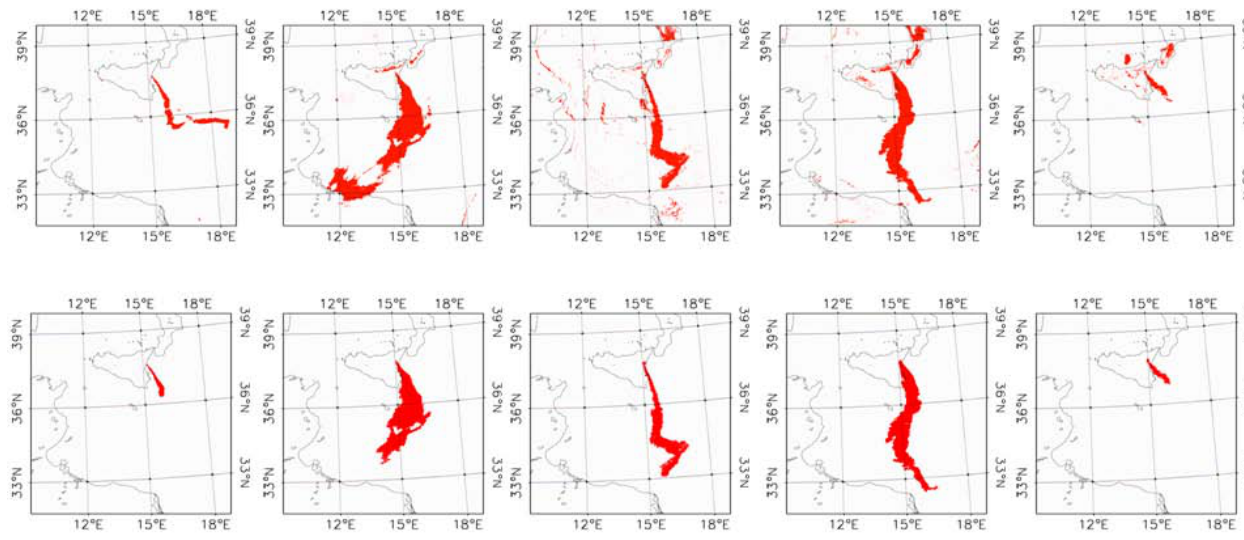
Fig. 5. MODIS NNs procedure ash maps. From left to right: 23 July 2001, 28 October 2002, 29 October 2002, 30 October 2002, and 24 November 2006. (a) Upper part maps without segmentation step. (b) Lower part maps with segmentation